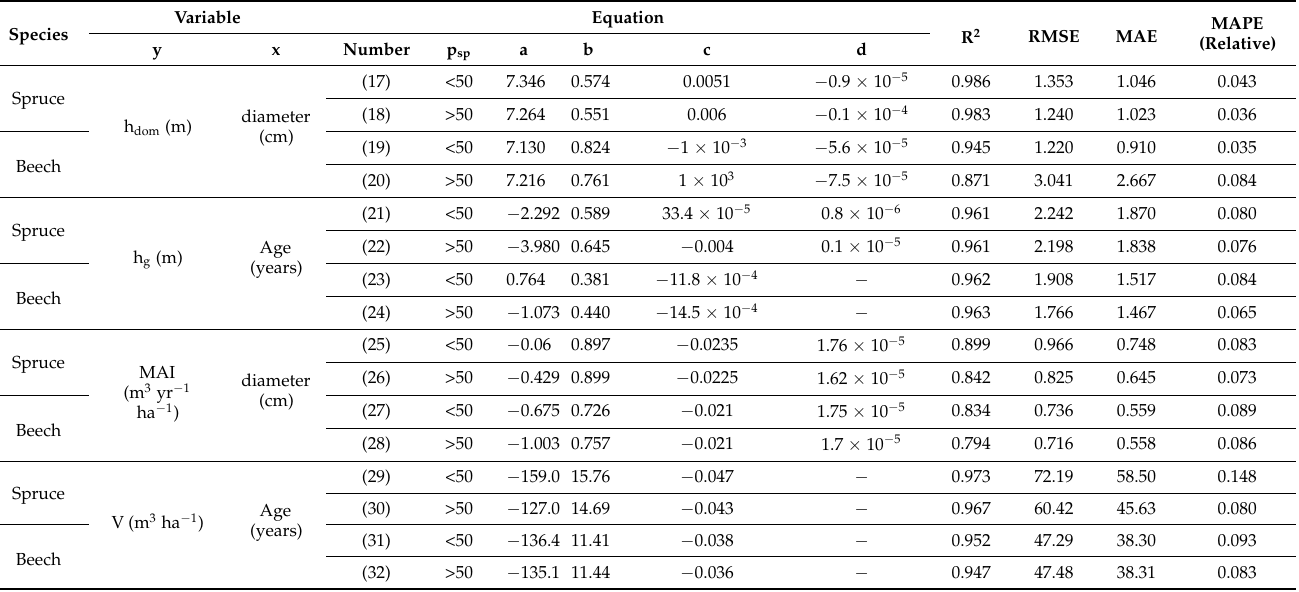
Table 8. Statistical parameters of the models used in the relationship between species proportion and stand